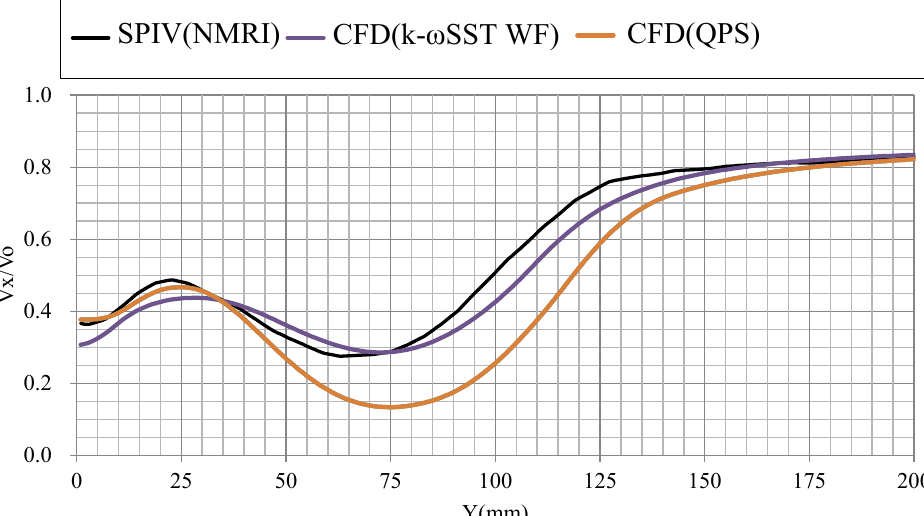
Figure 10. Longitudinal velocity distribution along the horizontal line above the propeller shaft calculated by wall function models.